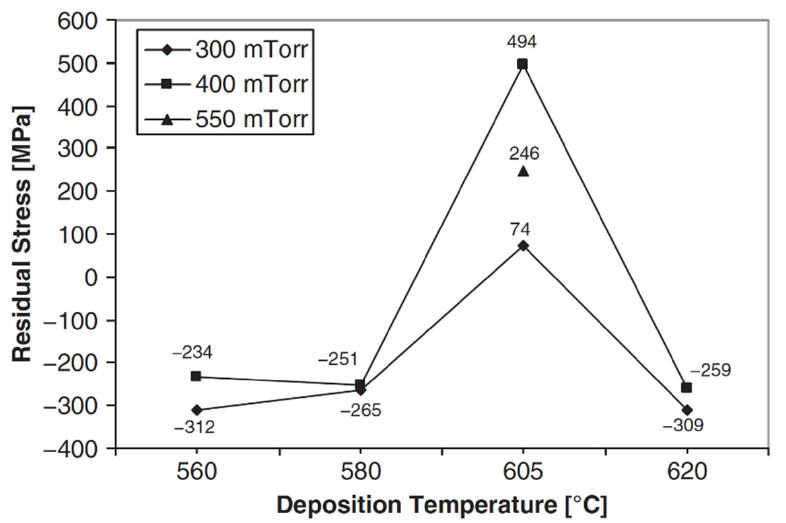
Figure 20. The residual stress in as-deposited polysilicon thin-films with varying deposition pressures and temperatures at a silane flow rate of 30 sccm [79].